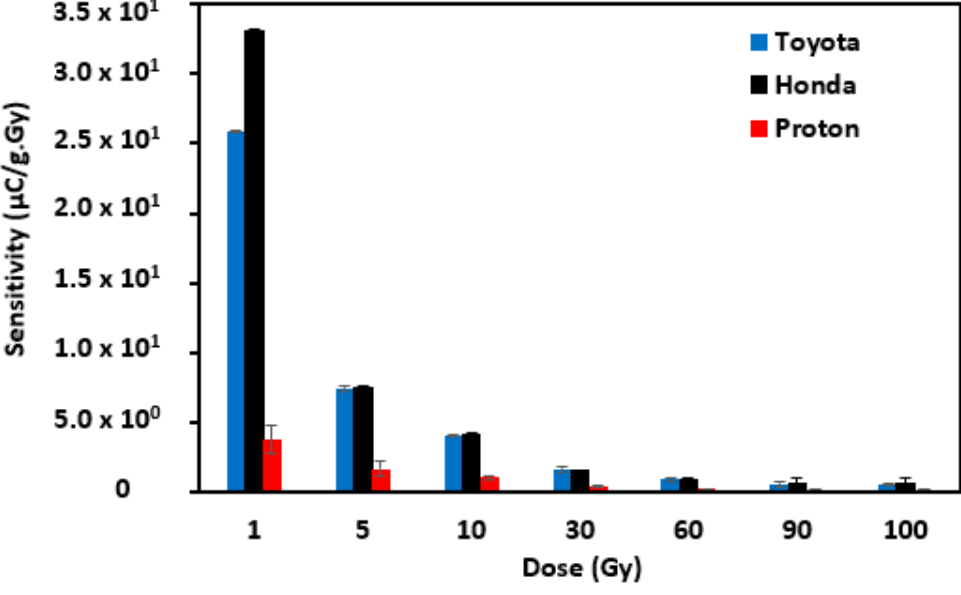
Figure 3. TL sensitivity of glass samples, for doses from 1 to 100 Gy, delivered by 60 Co.